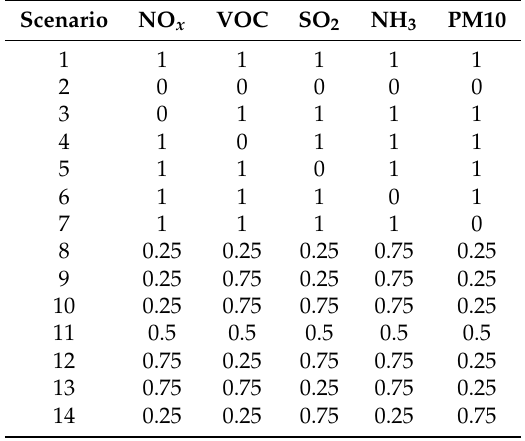
Figure A1. Schematic representation of the input configuration. Table A2. Emission reduction coefficients for the different scenarios and the 5 considered PM 10